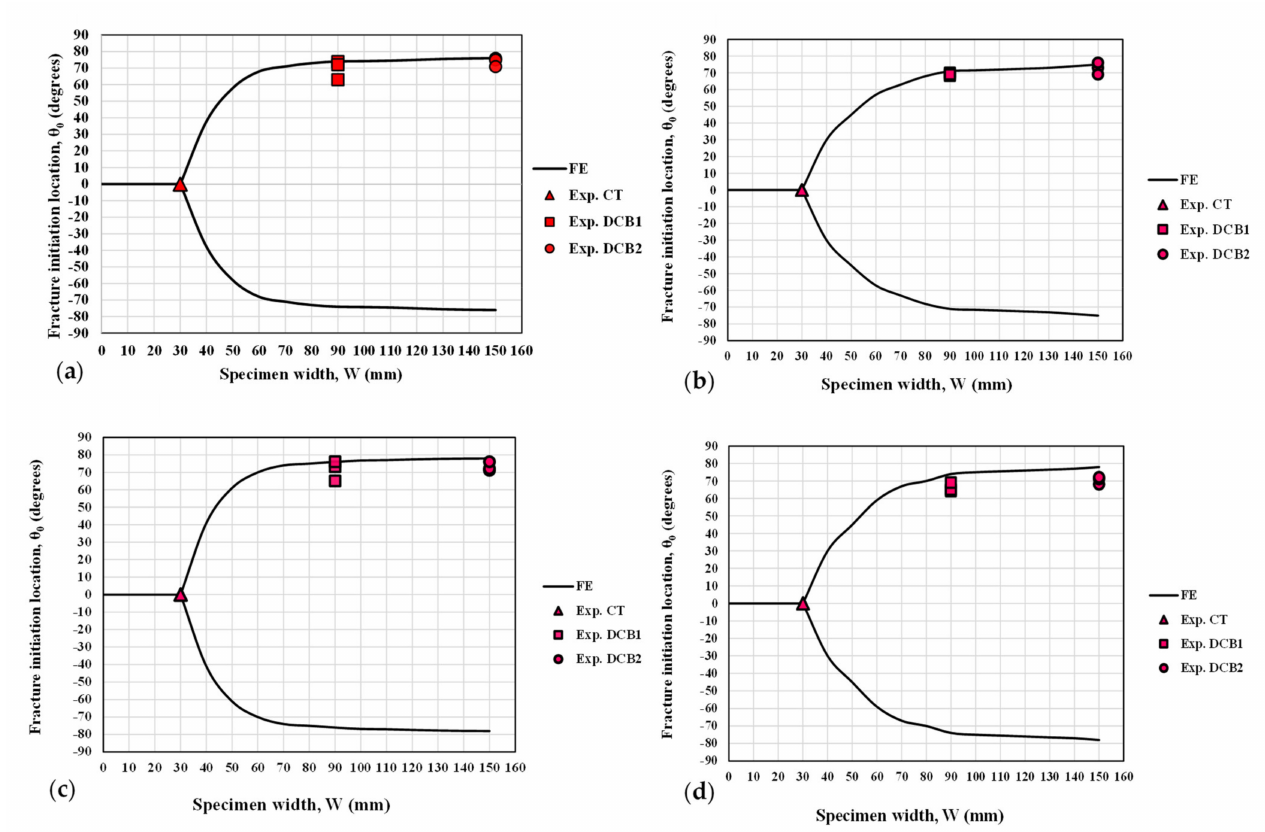
Figure 11. Crack initiation location predicted via GMTS and comparison with the corresponding experimental results for the CT, DCB 1 and DCB 2 specimens: ( a ) γ = 15 ◦ , ρ = 2.5 mm; ( b ) γ = 15 ◦ , ρ = 3.0 mm; ( c ) γ = 30 ◦ , ρ = 2.5 mm; ( d ) γ = 30 ◦ , ρ = 3.0